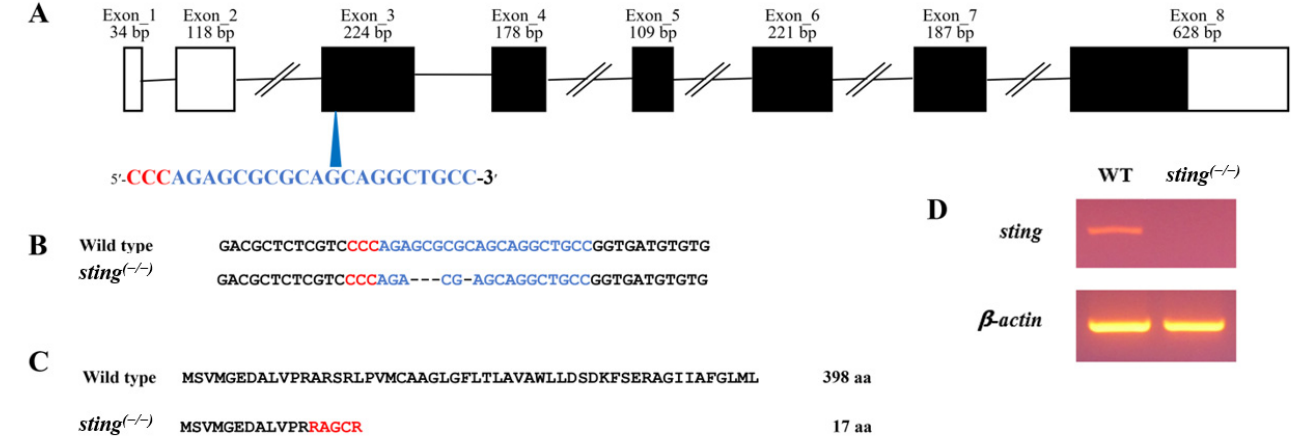
Figure 1. Generation of sting ( − / − ) zebrafish. ( A ) Schematic illustration of organization of zebrafish sting . The white and black boxes represent untranslated regions and open reading frames, respectively. The blue arrowhead indicates the single guide RNA (sgRNA) target site. The PAM and the sgRNA target sequences are indicated in red and blue letters, respectively. ( B ) The obtained mutation in sting ( − / − ) fish using CRISPR/Cas9 gene editing. Deleted nucleotides in the sting ( − / − ) genome are indicated with hyphens. ( C ) Amino acid prediction of Sting in the sting ( − / − ) and WT zebrafish genomes. The altered amino acids are represented with red letters. ( D ) Confirmation of mutation via RT–PCR using sting ( − / − ) mutation-specific primers in 7 dpf larvae of sting ( − / − ) and WT zebrafish.